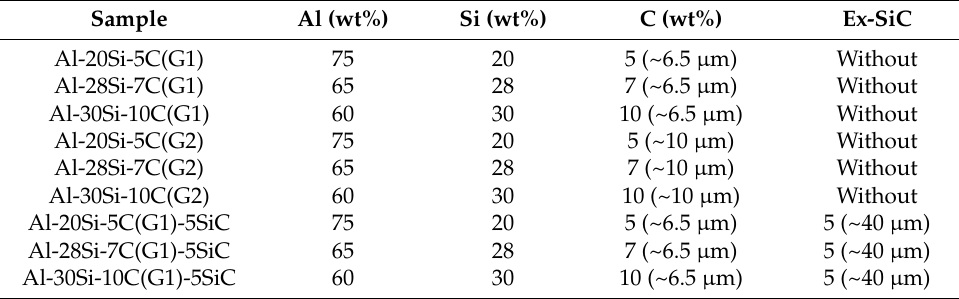
Table 1. AMC samples prepared from different starting